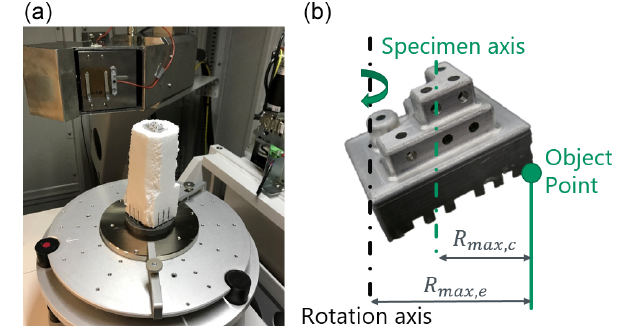
Figure 1. Clamping of the specimen on the rotary table of the CT system (a) and representation of the dependence of the result- ing distance on the clamping (b) in the eccentric case. For centric clamping, the axis of rotation and specimen axis